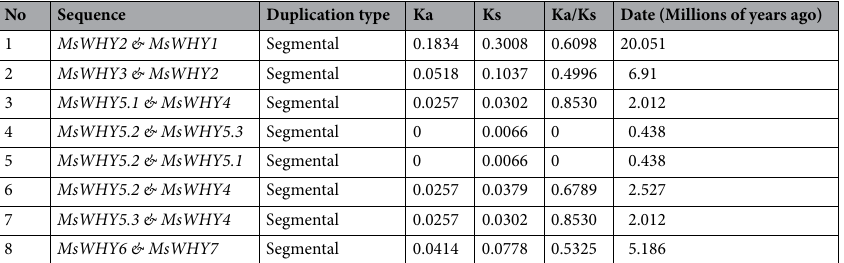
Table 3. The duplication events of MsWHYs identified in